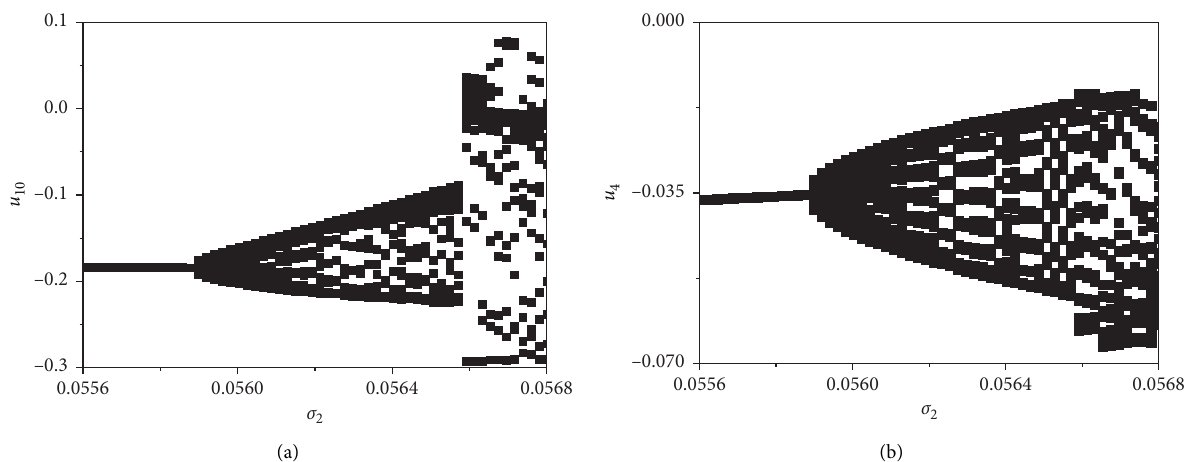
Figure 12: Bifurcation diagrams of the cable (a) and shallow arch (b) with the excitation acting on the arch.